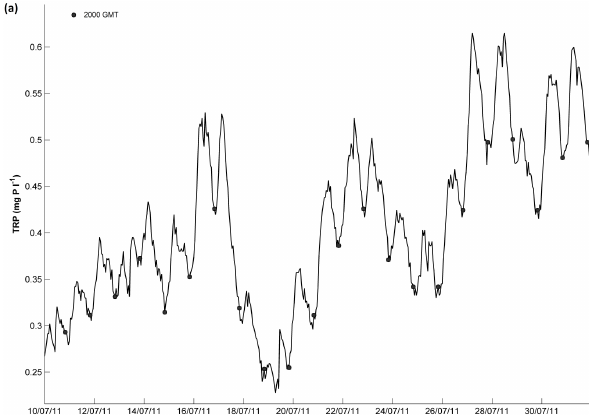
Fig. 9. Diurnal patterns within the observed streamwater TRP con- 3 centrations in The